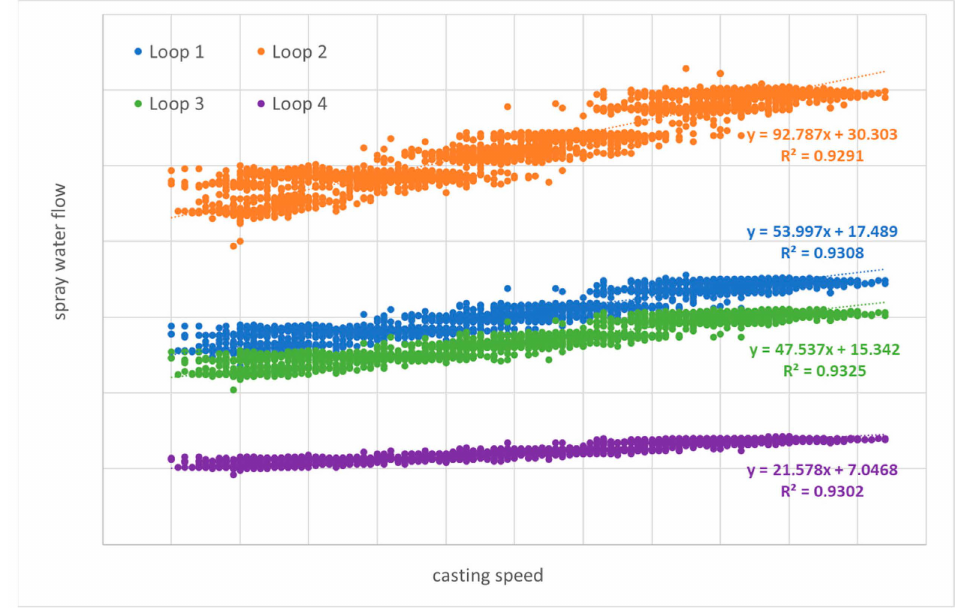
Figure 16. Spray water flow rates vs. casting speed for sequence casted at